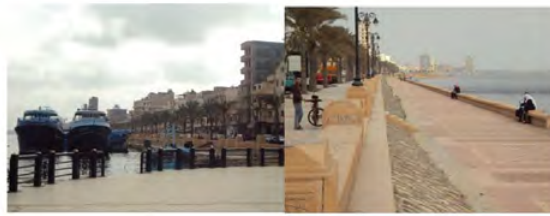
Figure 12. (Rashid waterfront)